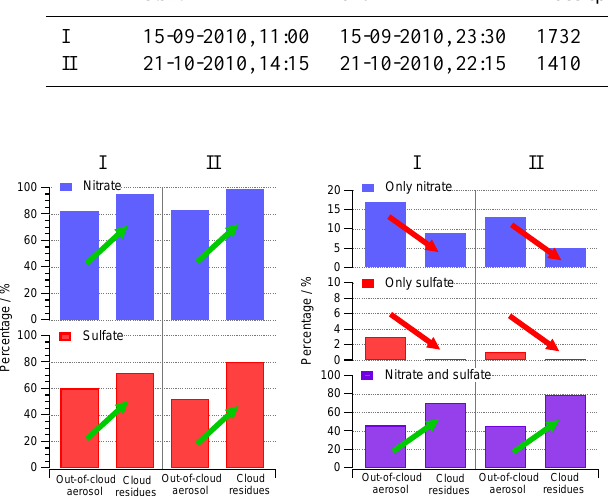
Table 5. Cloud and out-of-cloud periods (local time) used for the investigation of the mixing state of the particles. Event Out-of-cloud aerosol Cloud residues